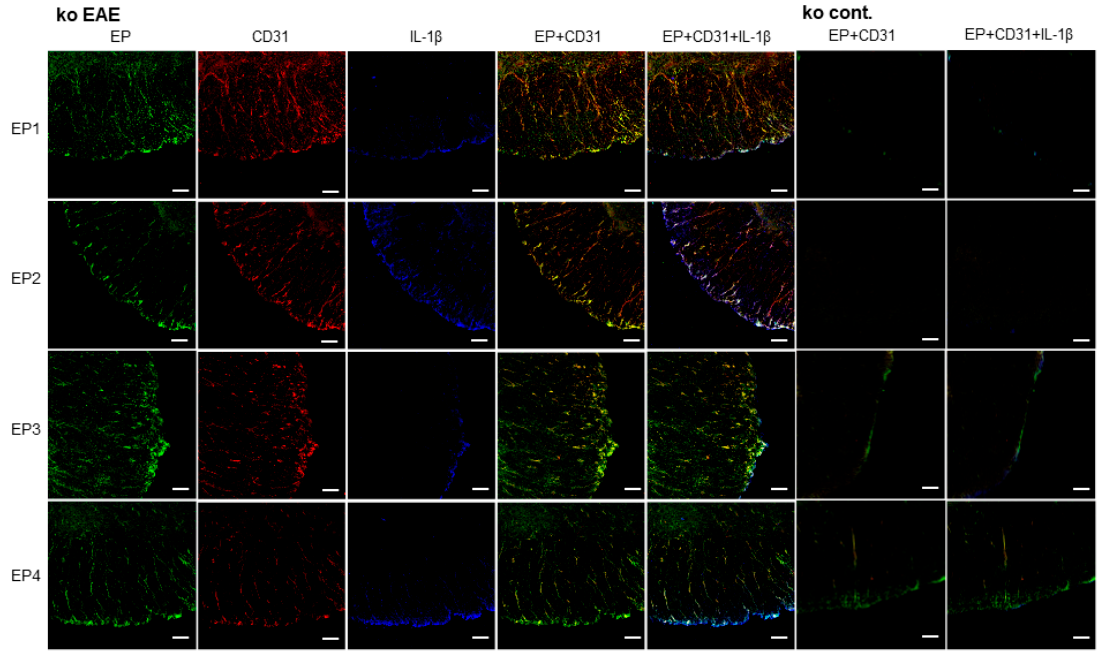
Figure 6. Expression of E-prostanoid (EP) receptors and interleukin-1 β (IL-1 β ) in CD31-positive (CD31 + ) endothelial cells (ECs) in spinal cords in microsomal PGE synthase-1-deficient ( mPGES-1 − / − ) mice. Immunohistochemical images showing EP1–4 (green), CD31 (red), and IL-1 β (blue) in the inflammatory region of the spinal cords of experimental autoimmune encephalomyelitis (EAE) mPGES-1 − / − mice ( mPGES-1 − / − EAE) and in the naïve spinal cords in mPGES-1 − / − control mice ( mPGES-1 − / − cont.). Scale bars are 20 μ m (for all images). ko, mPGES-1 − / − ; EAE, EAE mice; cont., naïve mice.